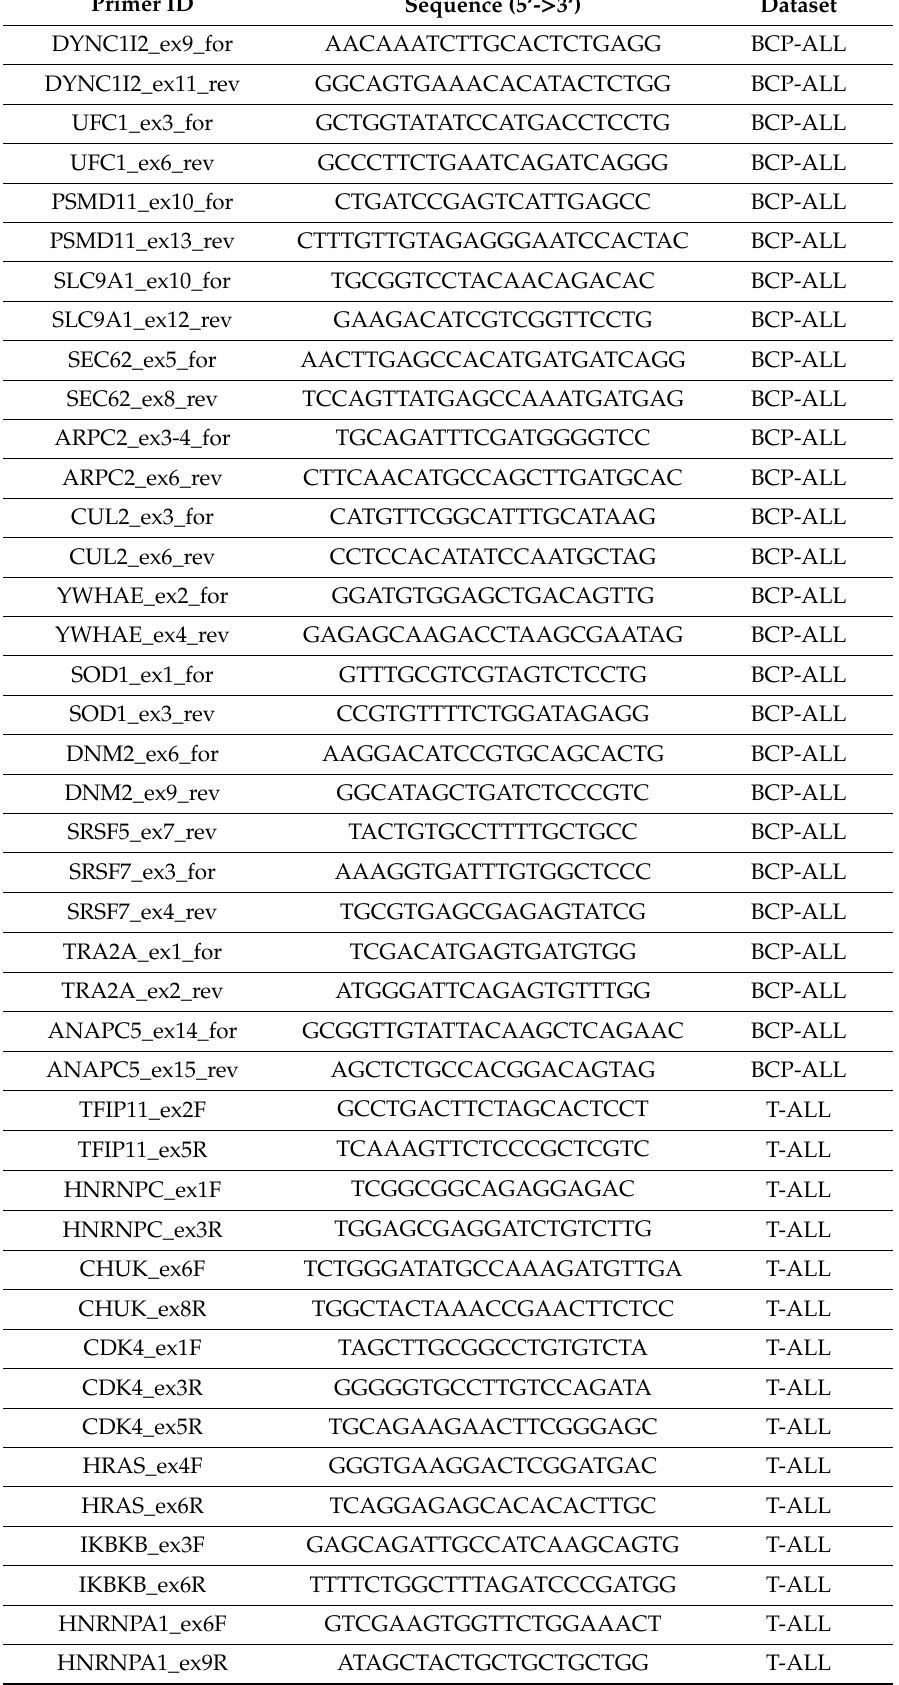
Table A3. The list of primers used in this